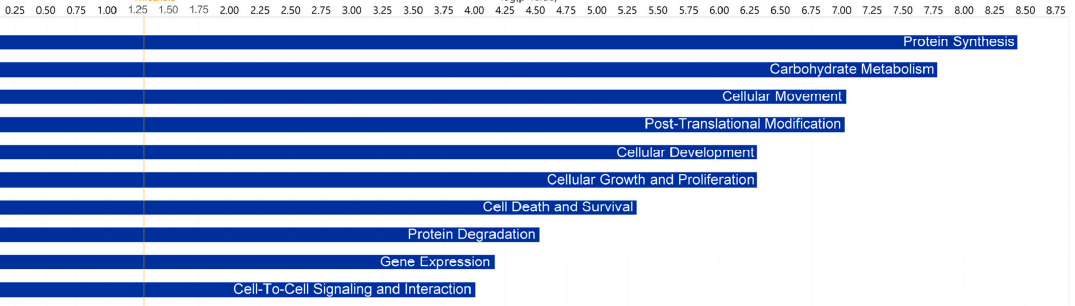
Figure 2. A functional analysis of the differentially expressed proteins with Ingenuity Pathway Analysis in sSS ‐ DED patients versus non ‐ SS ‐ DED patients indicated its top association with pro ‐ tein synthesis.